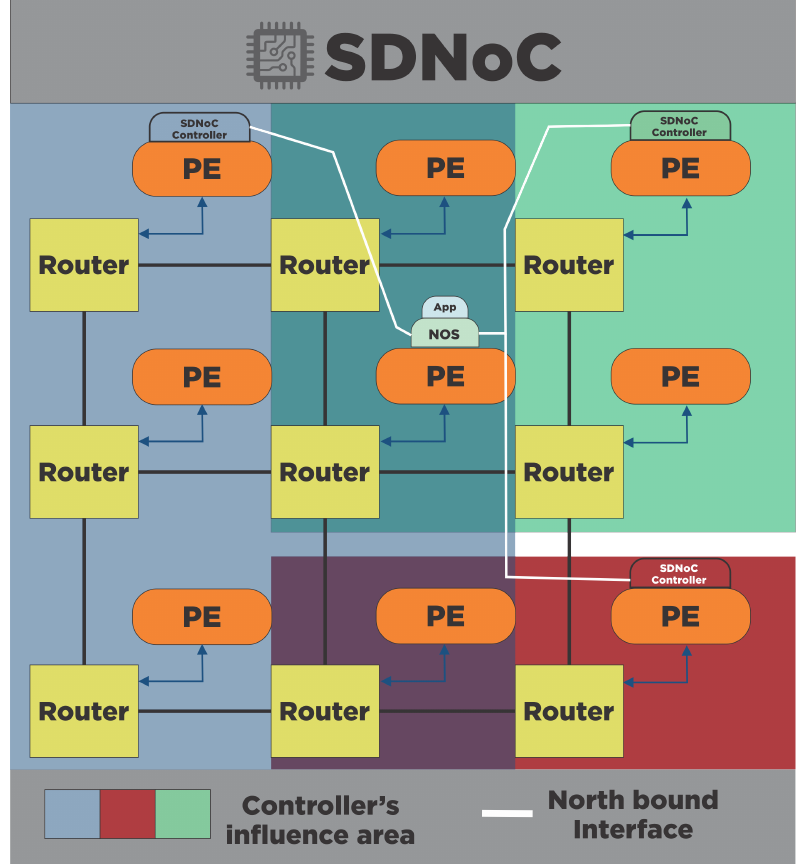
Figure 6. Distributed implementation of an SDNoC architecture. The illustration shows the SDNoC controllers’ influence area. The distributed SDNoC implementation spreads the software components among several processing elements in the NoC. The northbound interface, between NOS and SDNoC controller, is shown as a white